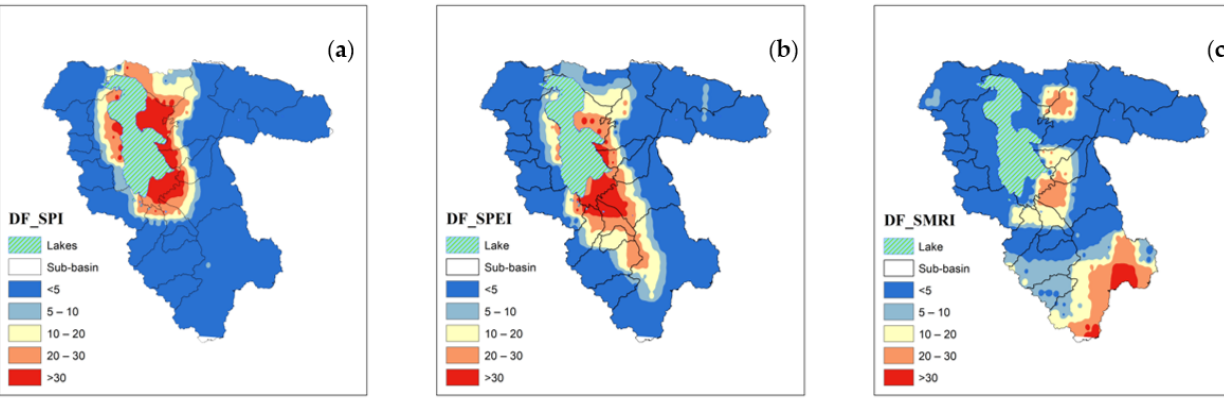
Figure 12. Drought Severity (DS) maps over ULB basin. ( a ) SPI dry year, ( b ) SPEI dry year, ( c ) SMRI dry year, ( d ) SPI drier year, ( e ) SPEI drier year and ( f ) SMRI drier year. Based on Table 2 threshold <−1 considered as drought hot spots [91].